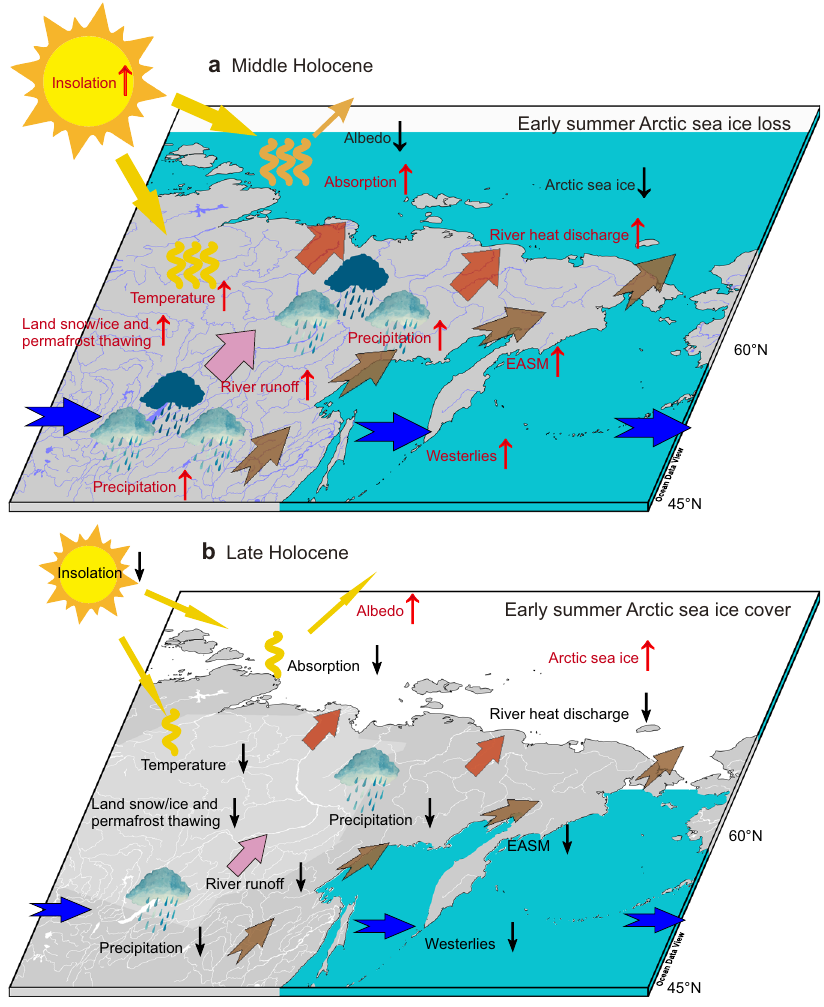
Fig. 4 | Mechanisms of Russian pan-Arctic river heat discharges on Arctic sea ice changes. a During the mid-Holocene, the intensi fi ed early summer solar insolationresultedinmid-and high-latitudeAsianpositivetemperatureanomalies and enhanced the river runoff that originated from reinforced permafrost, land snow/ice thawing, and river basin precipitation. Meanwhile, the increased pre- cipitationandassociatedheatcontentweremainlyfromthelowerlatitudesdueto theenhancedmeridionalmoisturegradient,whichcouldhavebeentransportedby